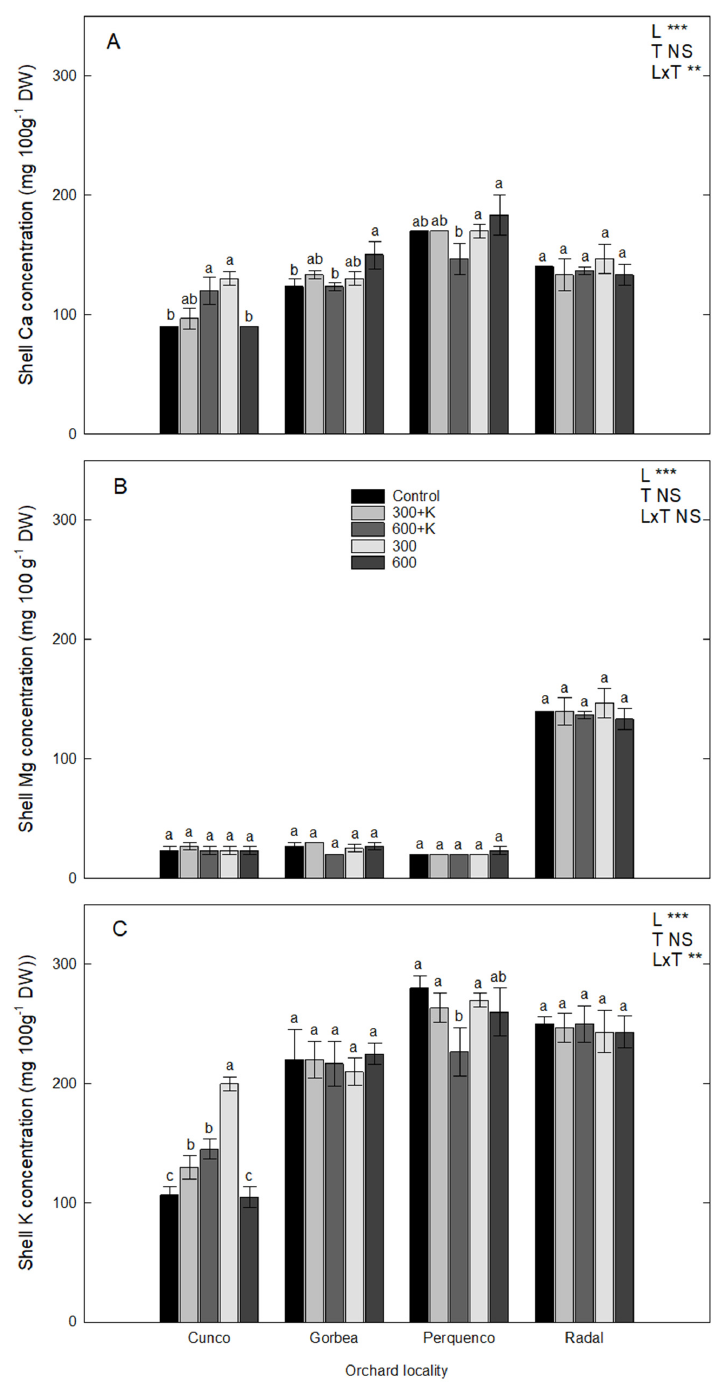
Figure 2. Calcium ( A ), Mg ( B ) and K ( C ) concentrations (mg 100 g − 1 DW) in the shells of TDG hazelnuts after the foliar spraying of Ca, Mg and K in four orchard localities in the La Araucan í a region. Bars represent the average of four replicates ± S.E. Different letters indicate statistical differences ( p ≤ 0.05) between treatments in the same locality. Two-way ANOVA results are shown; NS: not significant; ** p < 0.01; *** p < 0.001. Control (water), 300+K (Ca+Mg+K at 300 mg L − 1 ), 600+K (Ca+Mg+K at 600 mg L − 1 ), 300 (Ca+Mg at 300 mg L − 1 ), and 600+K (Ca+Mg at 600 mg L − 1